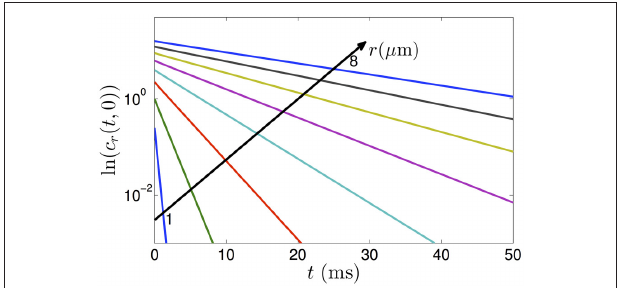
FIGURE 1 | The logarithm of the positional autocorrelation function of diffusing particles in cylinders with radii varying from 1 to 8 µ m . The plots show that the autocorrelation functions decrease approximately as exponential functions of diffusion